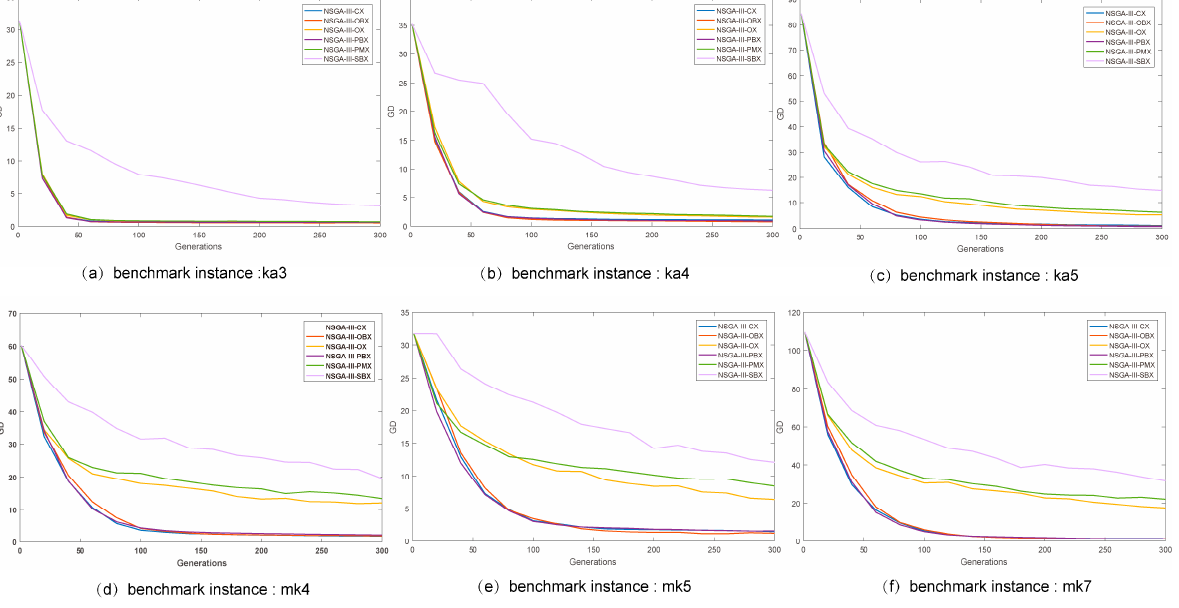
Figure 3. At population size of 300, the evolutionary trajectory of the GDs of the NSGA-III variants on the six FJSP instances (the average of the results of 30 independent runs; the initial population is a random population).